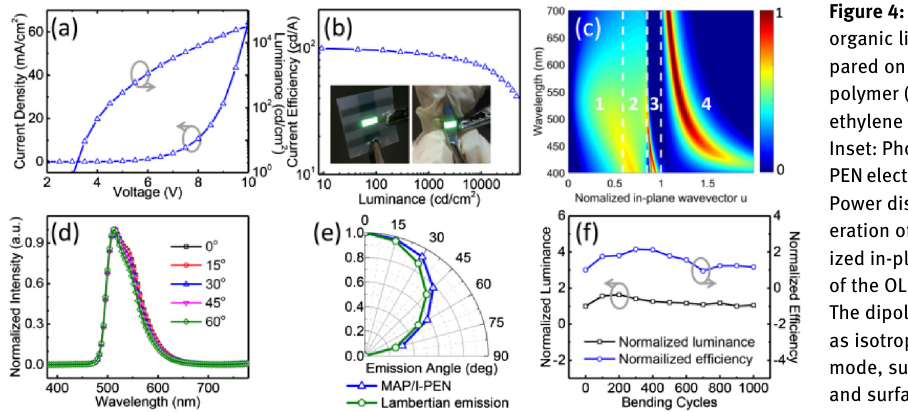
1 – 2 corresponds to the total light emitted to a substrate when it is regarded as infinitely thick. (d) – (e) Electroluminescent (EL) intensity as a function of emission angle of the MAP/I-PEN based devices. (f) Normalized luminance and current efficiency versus bending cycles with 8 mm bending radius for the flexible